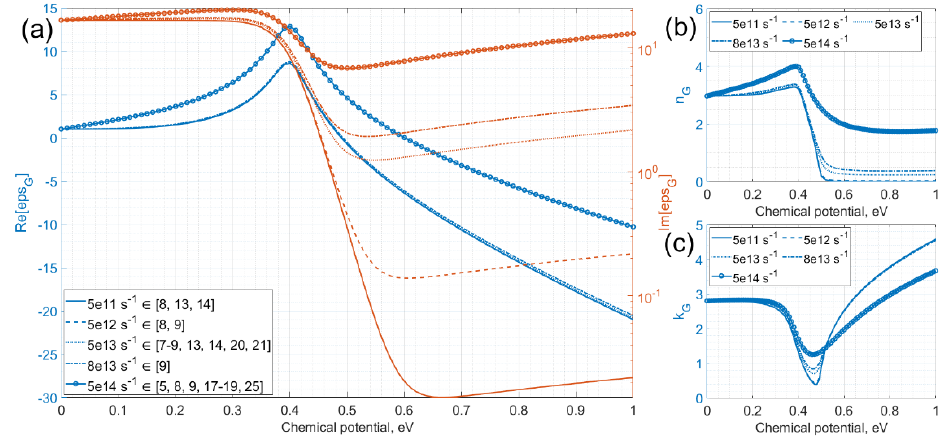
Figure 3. ( a ) Real (blue curves) and imaginary (red curves) parts of the permittivity, ( b ) refractive index and ( c ) extinction coefficient as a function of the chemical potential for different values of relaxation rate from various publications ( λ = 1.55 µ m, t G = 0.34 nm, µ c = 0 ÷ 1 eV, Γ = 5e11 ÷ 5e14 s − 1 , T = 300 K).